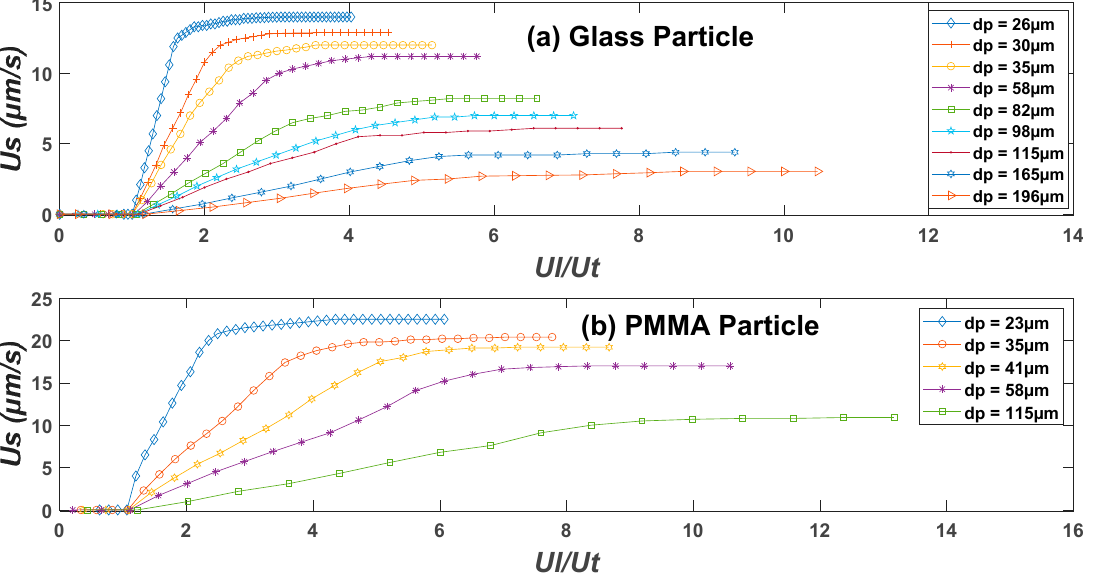
Figure 8. Particle circulating speed as a function of normalised velocity ( U l / U t ) for ( a ) glass and ( b ) PMMA particle. Errors are smaller than the symbols.